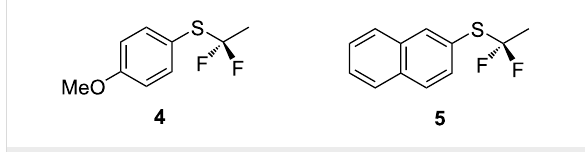
Figure 3: α , α -Difluoroethyl thioether substrates for metabolism